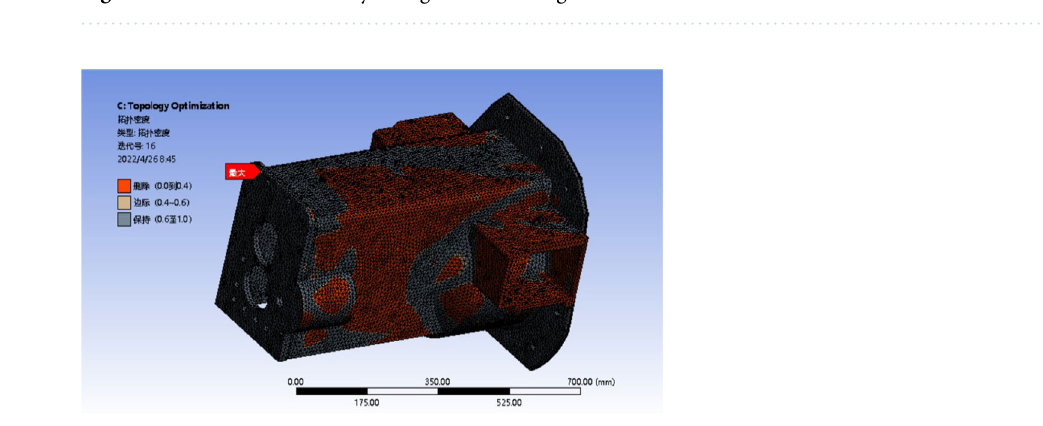
Figure 11. Optimization results with 50% mass